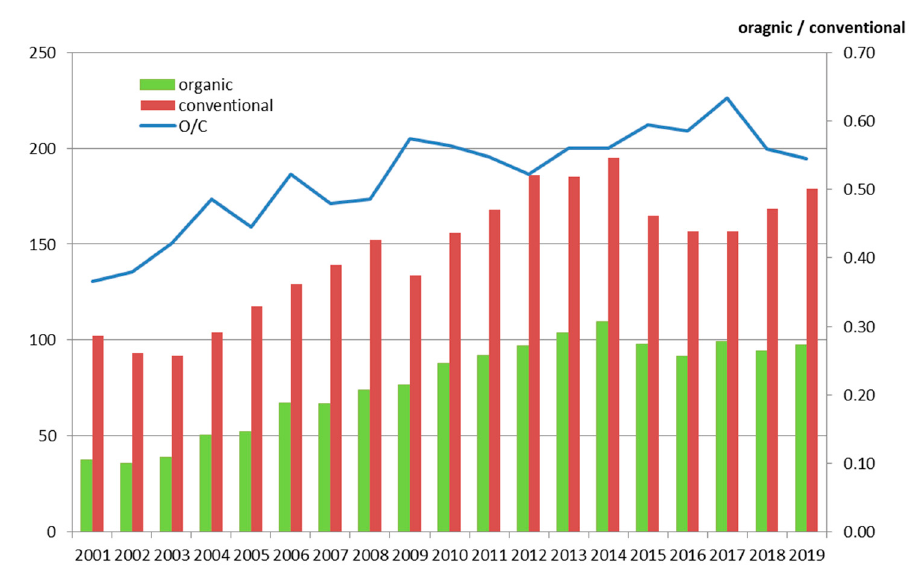
Figure 5. Energy consumption per one hectare in ANC. (Source: [38], authors’ elaboration).